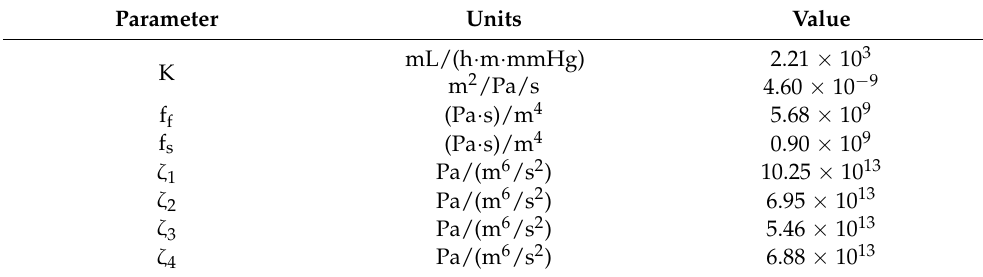
Table 1. List of determined parameter values from fitting the model to experimental